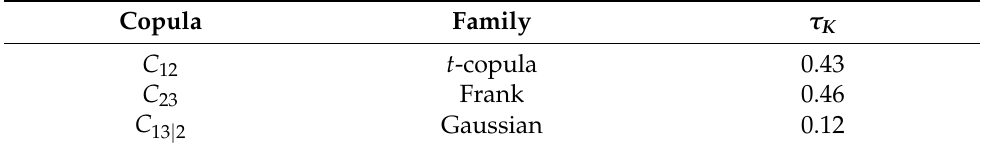
Table 2. Copula families, structure of the vine copula and values of Kendall’s tau τ K . Subscripts 1, 2 and 3 respectively indicate affected area, duration and